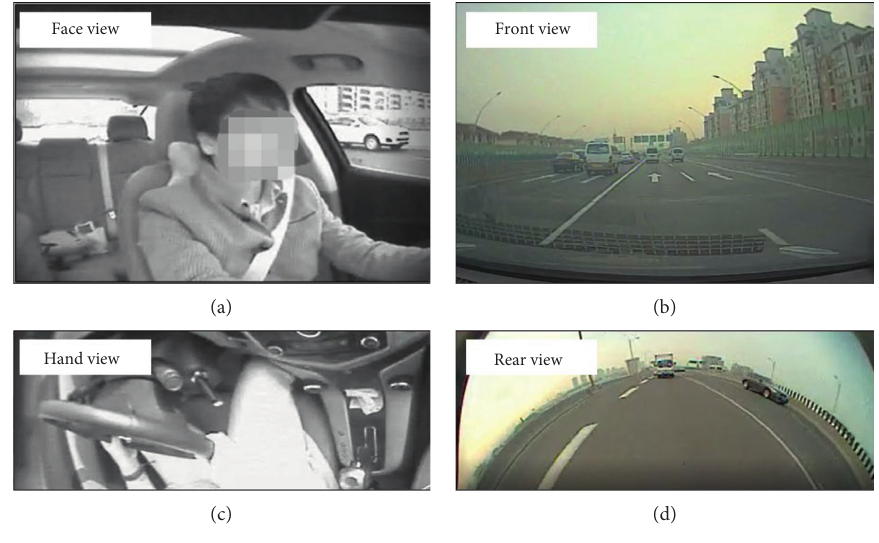
Figure 1: The video image of the